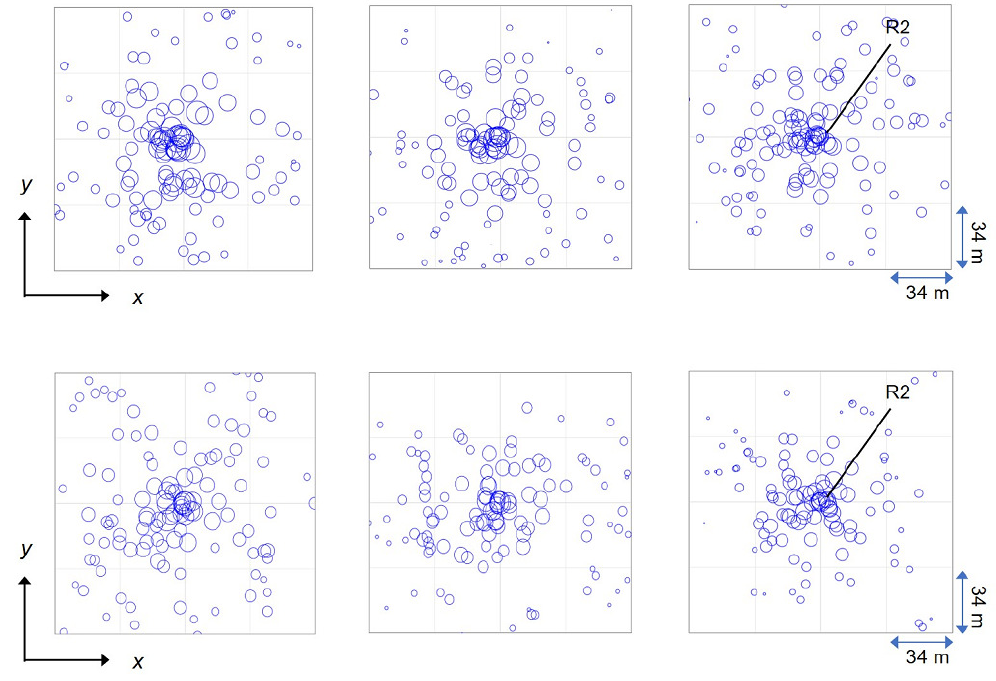
Figure A1. Visualized virtual source locations on the x – y plane for the source to receiver condition of S2 to R2 at 500 Hz and 1 kHz octave band in the cases of case 0 ( Left ), case 5 ( Center ) and case 6 ( Right ). The upper figures and the lower figures respectively present the cases at 500 Hz and 1